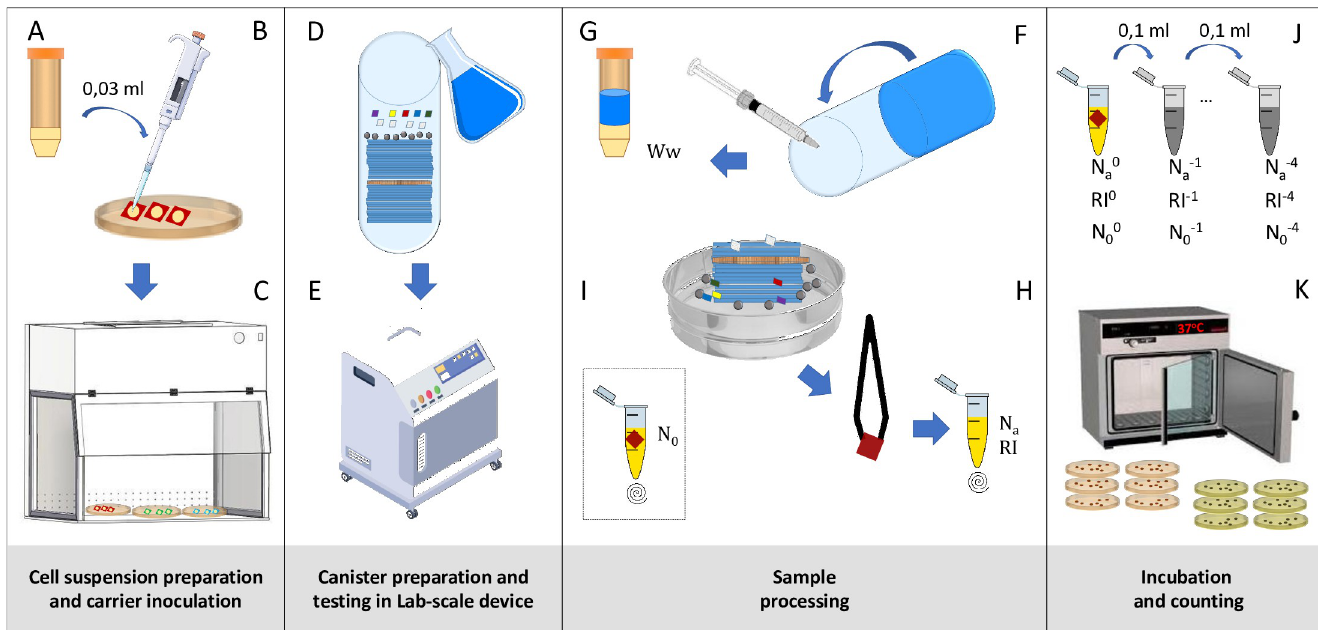
Fig 1. Method workflow. A : Cell suspension preparation for each strain tested. B : Carrier inoculation. C : Carrier drying process in the flow cabinet. D : Canister preparation. E : Testing time at the corresponding temperature in the lab-scale tumbling device. F : Wash water recovering and neutralizing. G : Content addressing. H : N a / R I carrier recovery and mixing in neutralizer. I : N 0 mixing in neutralizer. J : 10-fold dilution preparation. K : Plate incubation and